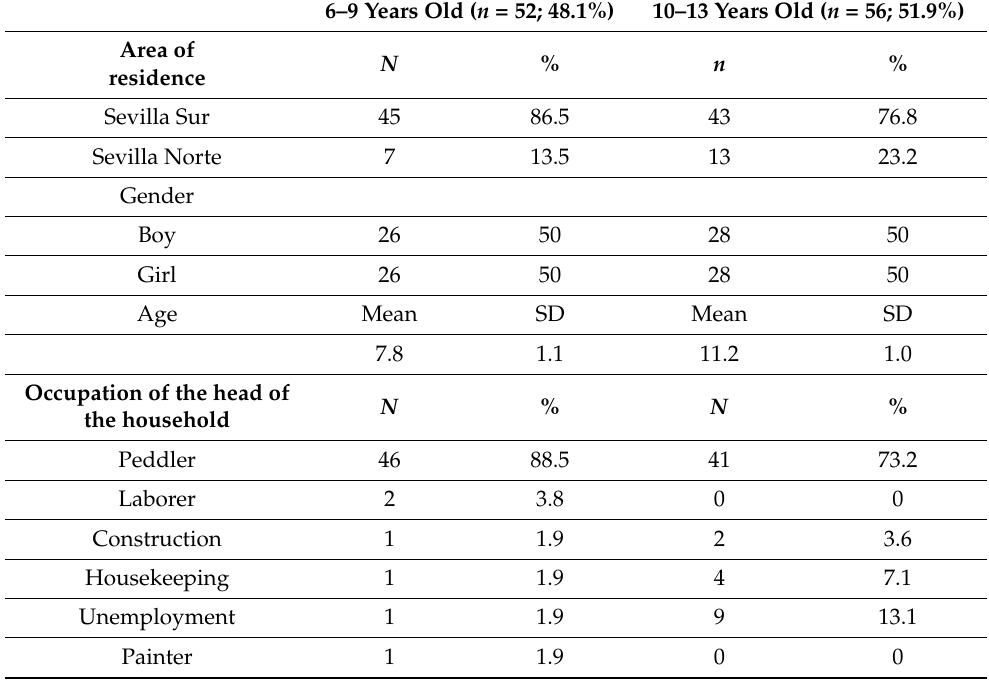
Table 1. Sociodemographic description of the study sample ( n = 108) according to age groups.